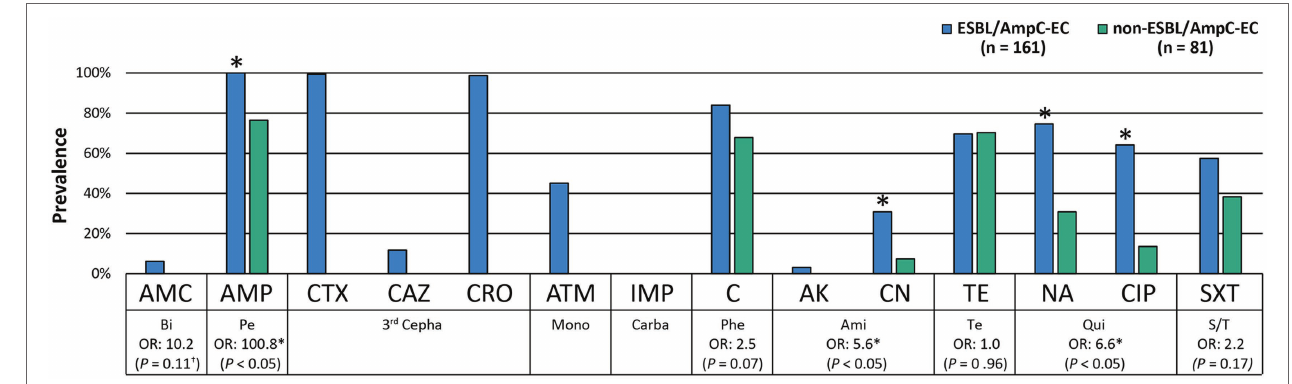
FIGURE 2 | ESBL/AmpC-EC showed significantly higher resistance rate to antibiotics compared to non-ESBL/AmpC-EC. Statistically significant ( * p < 0.05, GEE; † p < 0.05, Chi-square